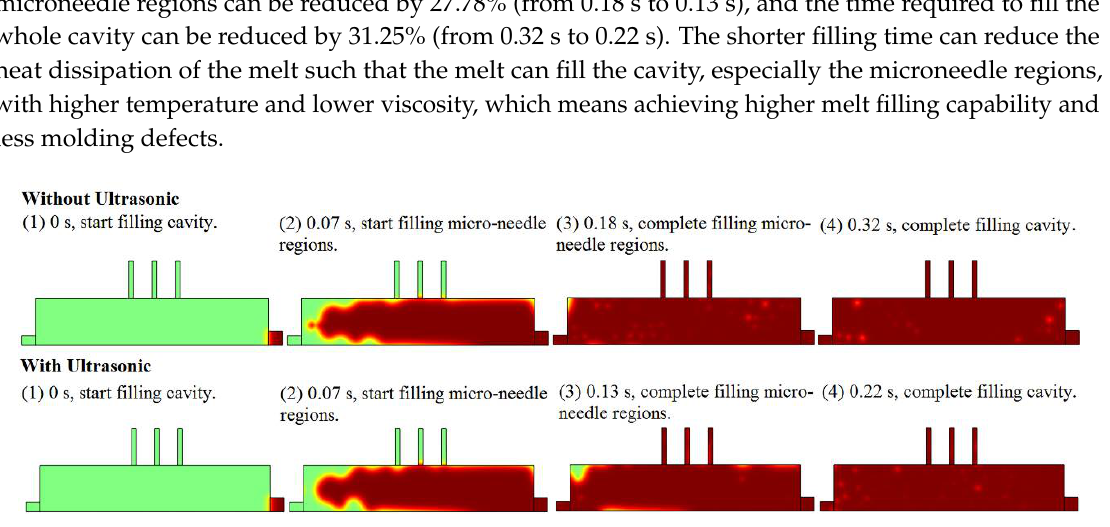
Figure 3. The filling process and volume fraction of melt in microneedle array cavity with and without the effect of ultrasonic vibration.